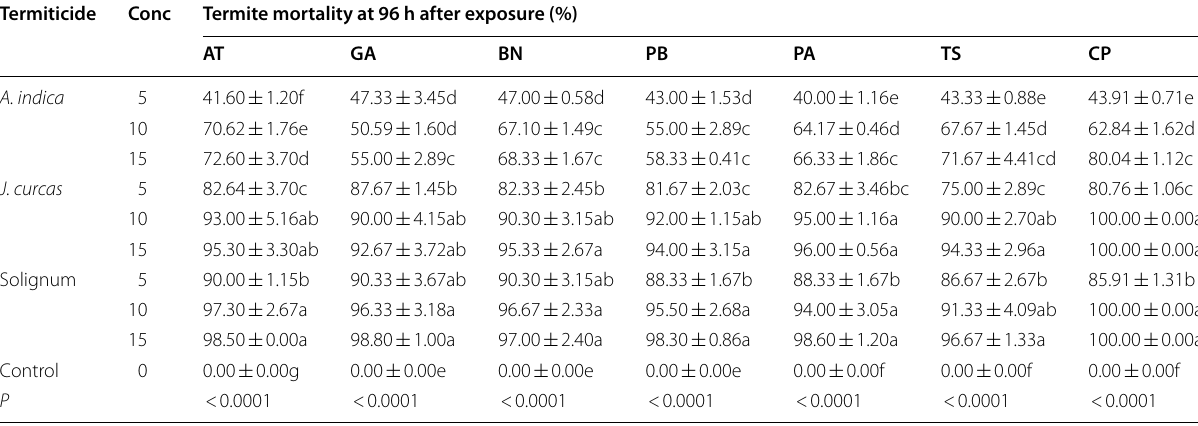
AT, Antiaria toxicera ; GA, Gmelina arborea ; BN, Baphia nitida ; PB, Parkia biglobosa ; PA, Pycnanhus angolensis ; TS, Terminalia superba ; CP, Ceiba pentandra ; Data (%) were transformed (arcsine) before the analysis of variance; Means ( in a column are not significantly different from each other (DNMRT: P > 0.05); b concentration (mL/ 100 m 3 of wood surface); P Table 5 Termite-induced weight loss in wood from seven plant species treated A. indica, J. curcas, and Solignum Termiticide